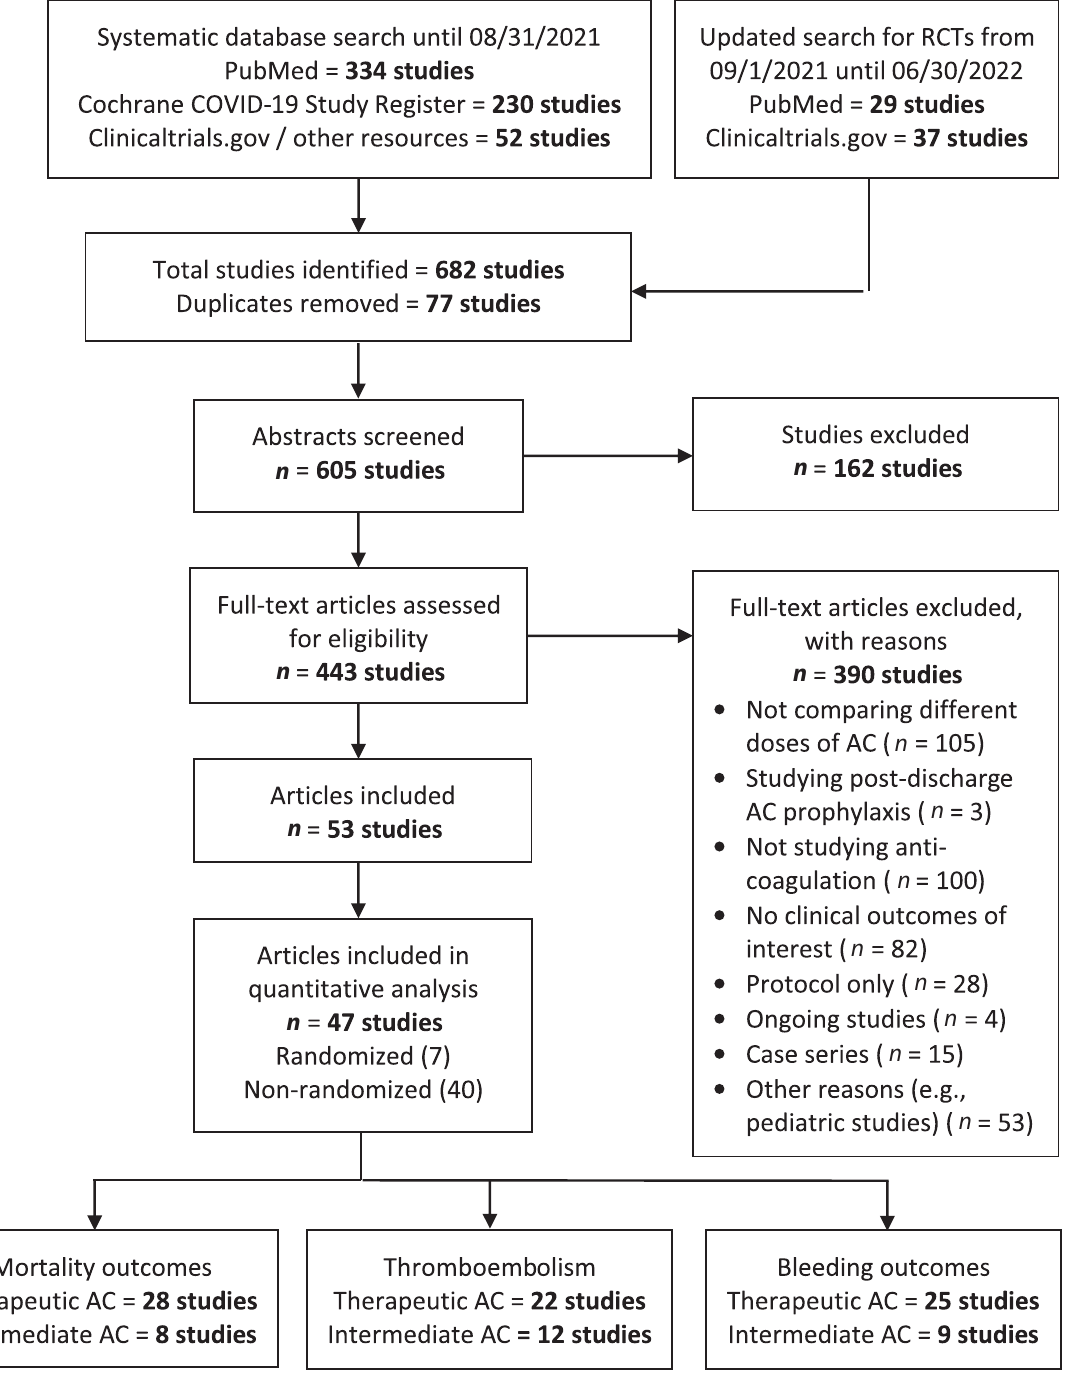
Fig. 1 Prisma fl ow